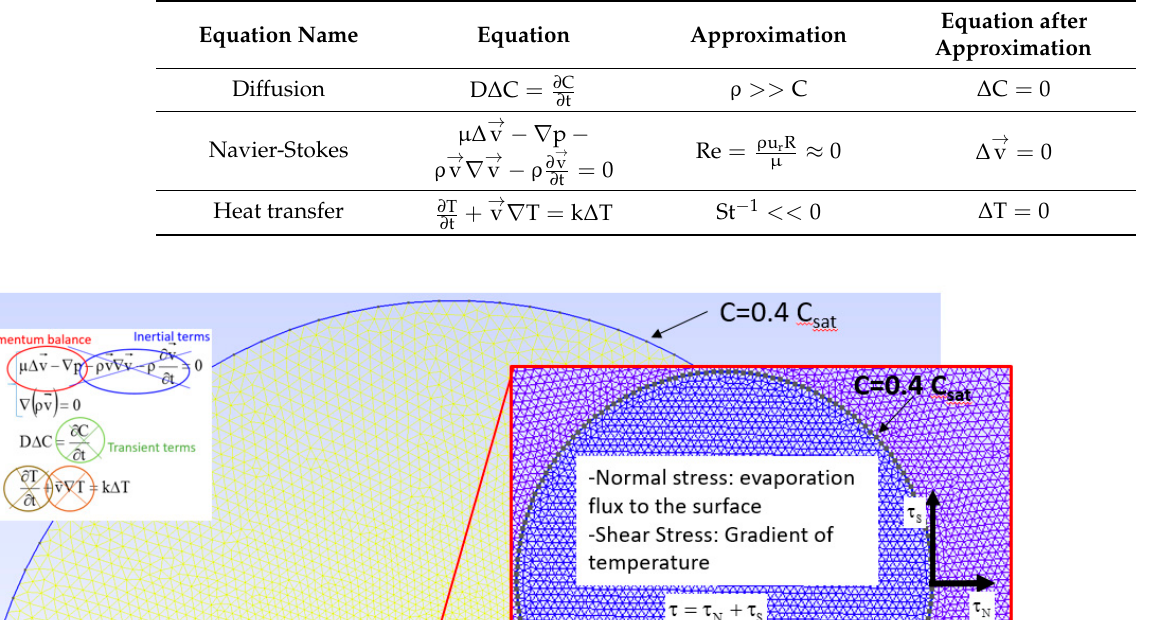
Table 1. Partial differential equations, approximations, and equations after approximations.